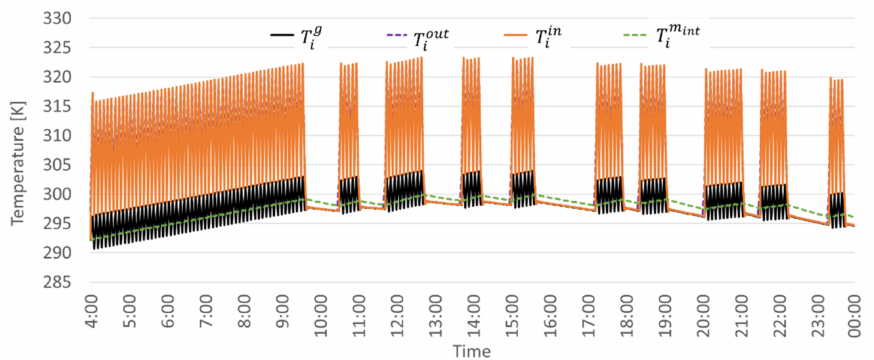
Figure 8. State and additional variables associated with the temperature in the reactive approach ( crt = 1 ) .